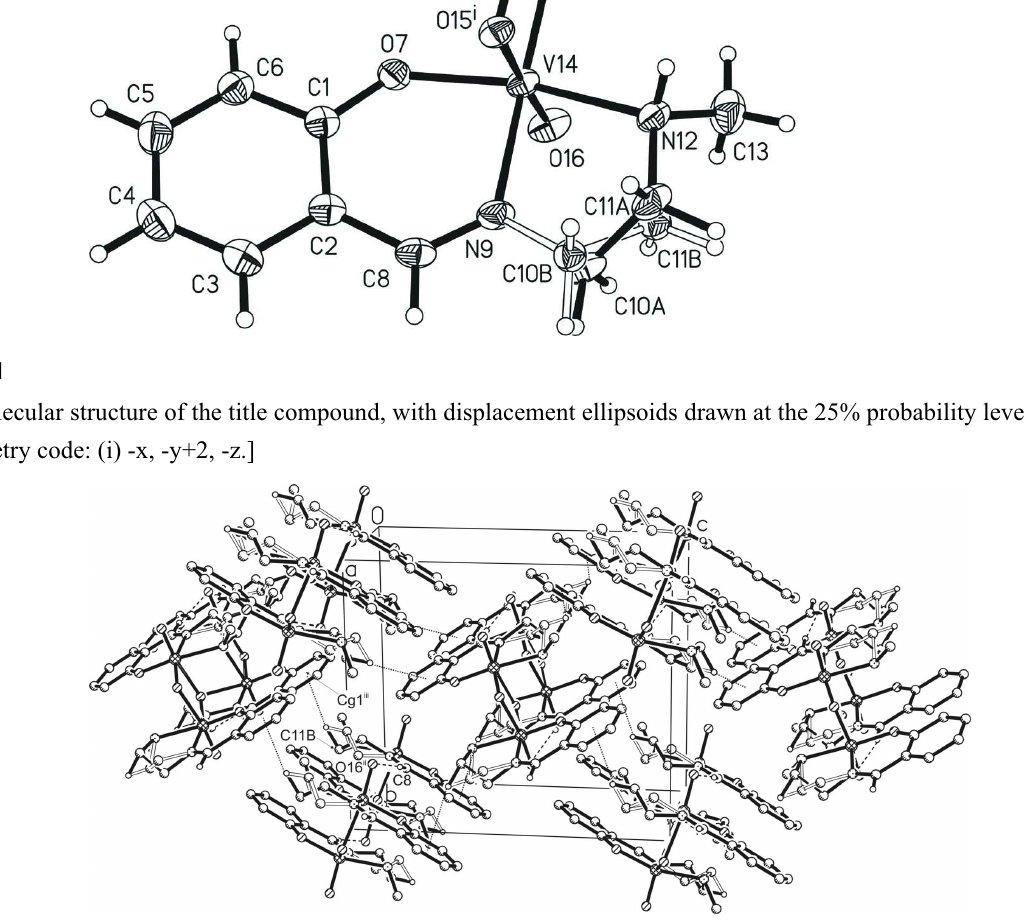
The arrangement of the molecules viewed approximately along the a -axis. The C—H···O hydrogen bonds are represented by dashed lines and the C—H··· π interactions are represented by dotted lines. [Symmetry codes: (ii) 1+x, y, z; (iii) x, 3/2- y,